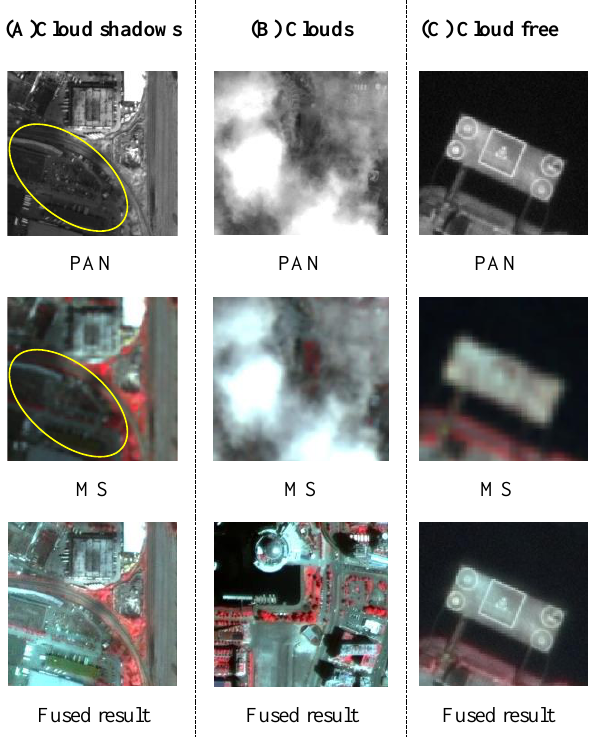
Figure. 4. Three typical zoomed-in areas, i.e., a region of cloud shadows, a region of clouds, and a cloud-free region, of the fusion result of the proposed framework,.